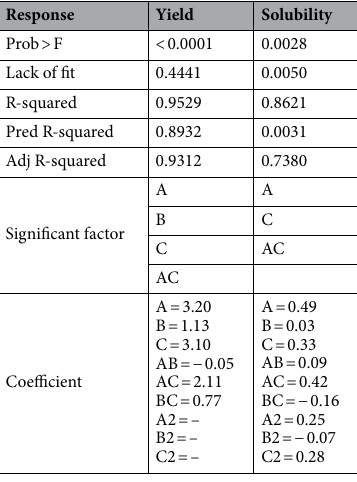
Table 6. ANOVA by CCD design for SFE of G.